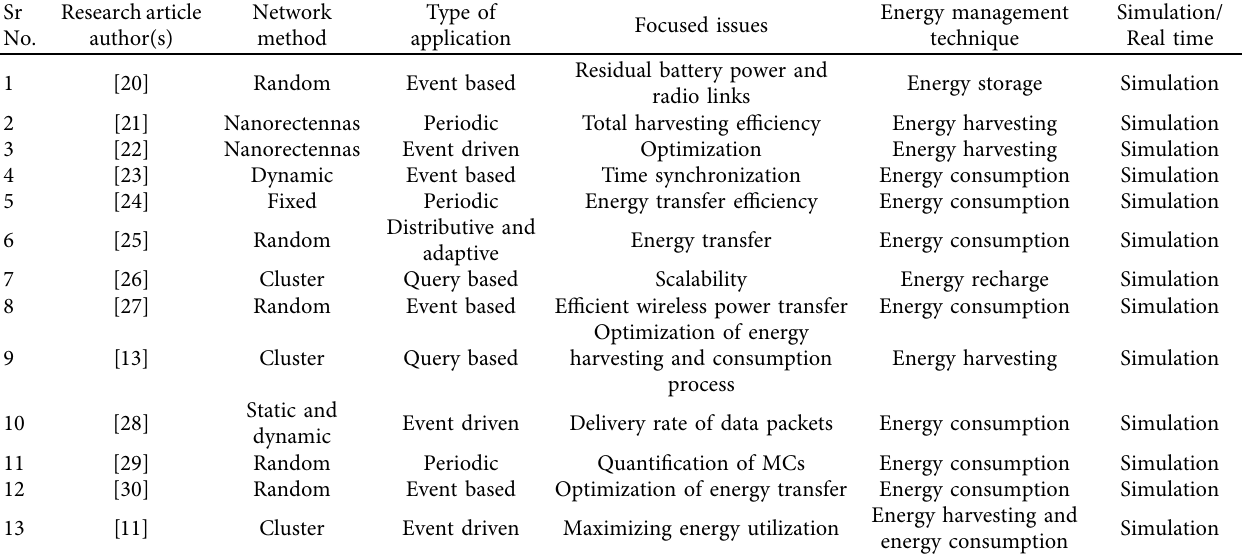
Table 2: Existing energy management techniques.